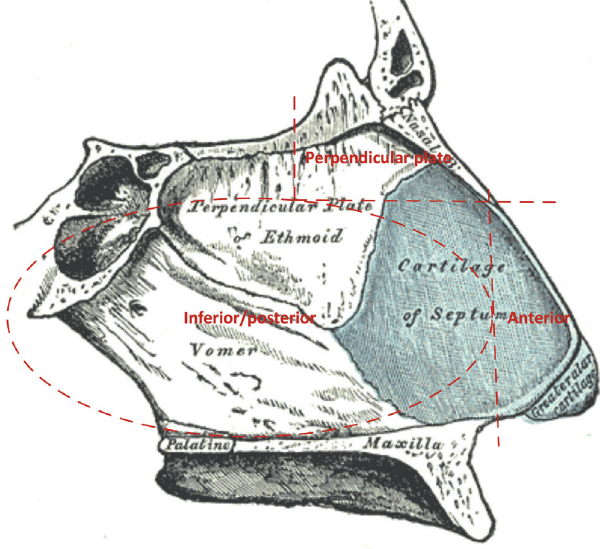
Figure 1. Subdivision of the nasal septum: anterior part, inferior/poste- rior part (vomer) and superior part (perpendicular plate).